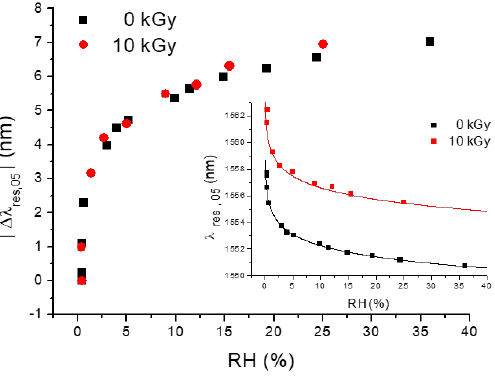
Figure 20. TiO 2 -coated LPG Rh characterization before (black points) and after (red points) 10 kGy dose of γ -ionizing radiation (from Ref. [126]).